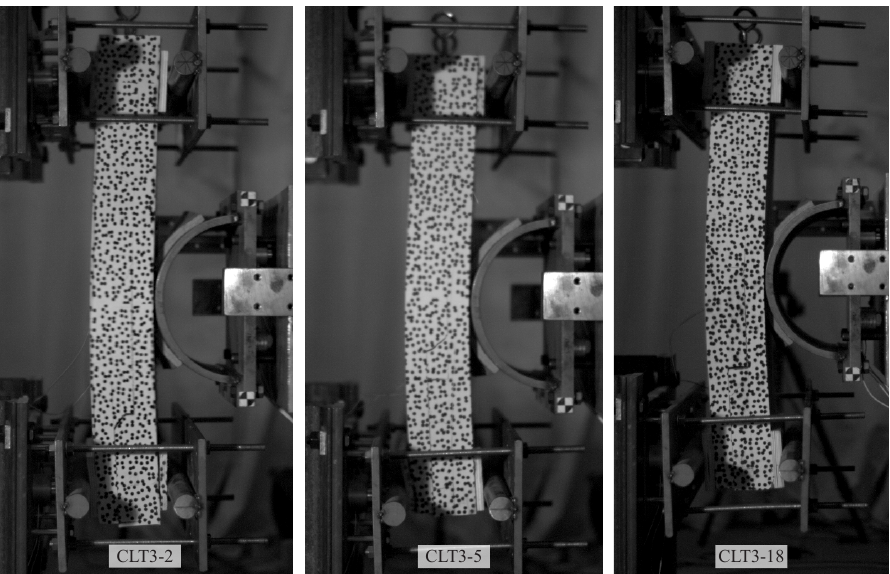
Figure 18. Comparison of damage in three-laminae clt at varied impact energies. From Left to Right: